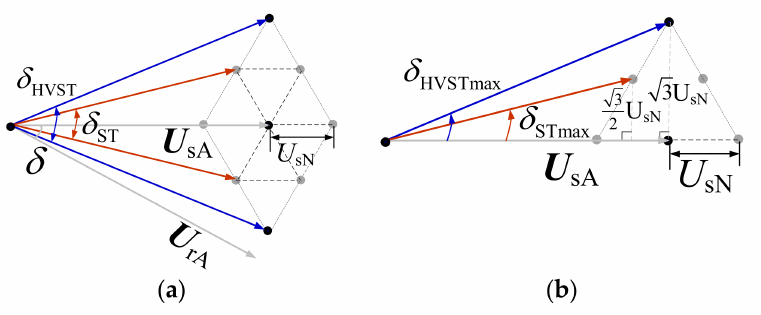
Figure 7. The phase-shift angles of the ST and the HVST. ( a ) The phase-shift range; ( b ) The maximum phase-shift